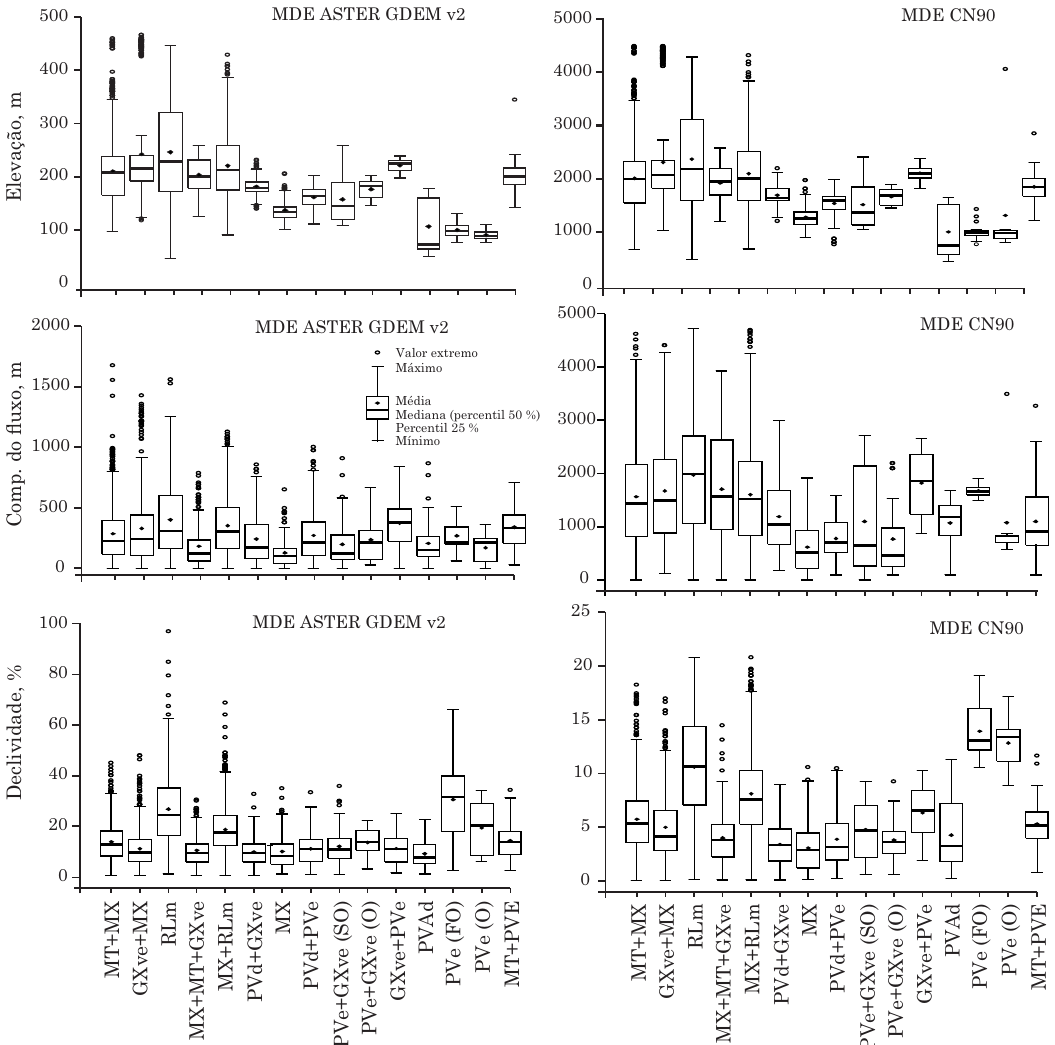
Figura 4. Gráficos de caixas dos dados de elevação, comprimento de fluxo e declividade derivados dos modelos digitais de elevação ASTER GDEM v2 (30 m) e CN90 (90 m) para cada unidade de mapeamento constante no mapa convencional de